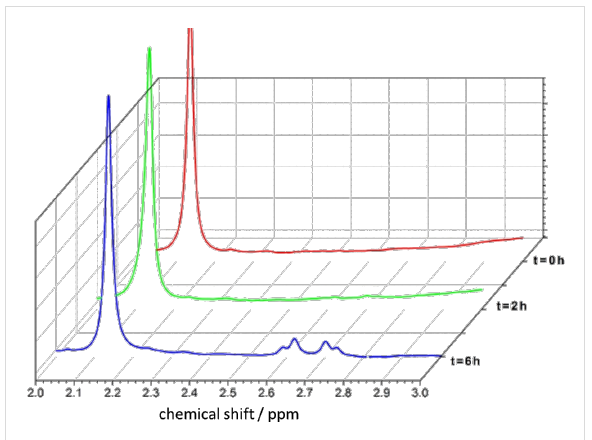
Figure 4: 1 H NMR spectra recorded at t = 0, after 2 and 6 h of irradi- ation in water. The selected range, 2–3 ppm, is diagnostic for NADH H-signals. The signal at 2.1 ppm results from the ribose hydrogen in the cofactor molecule and is taken as a reference peak. The concen- tration of the rhodium complex is 0.5 mM, with c glycerol = 0.05 M.